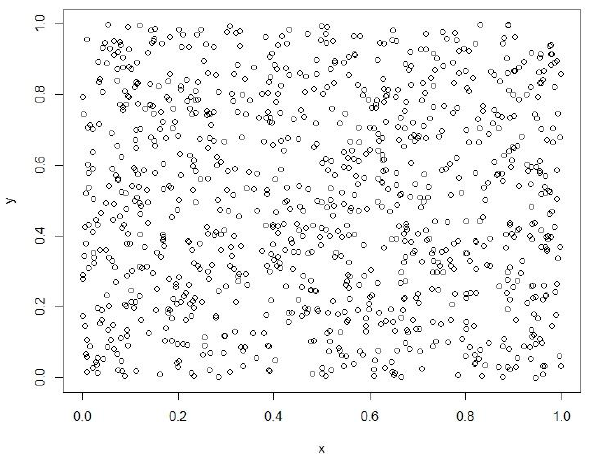
Figure 7. Pseudo-random distribution.